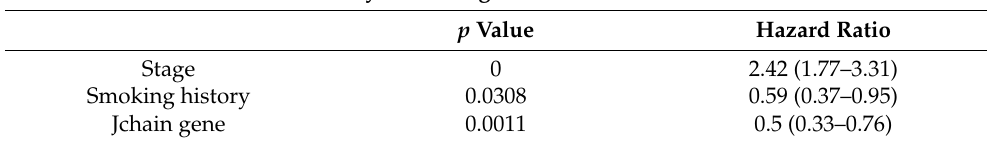
Table 4. Multivariate analysis considering overall survival in lung adenocarcinoma patients. Multi- variate analysis of J chain gene expression and smoking history and stage on overall survival in lung adenocarcinoma (n = 387) patients.